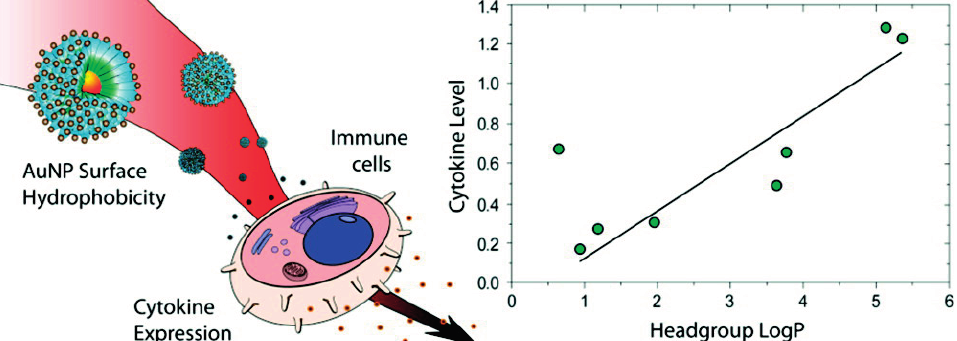
Figure 4. The surface hydrophobicity of GNPs (gold nanoparticles) dictates immune responses in splenocytes. Reprinted from [130] with permission from the American Chemical Society, Copyright